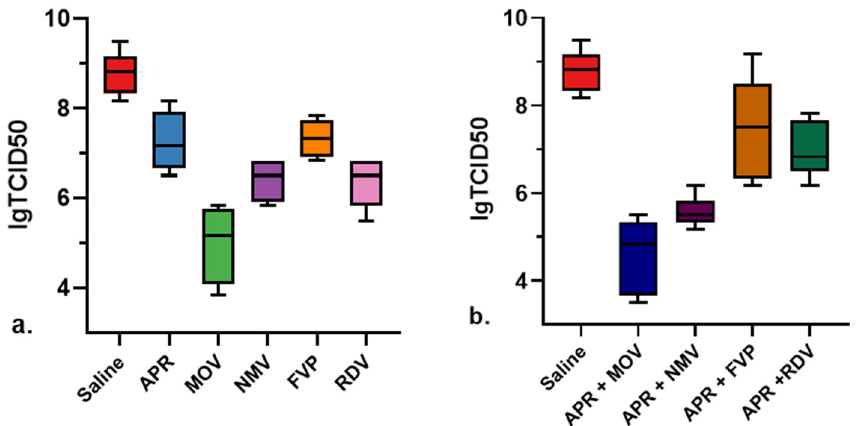
Figure 4. The titer value of the virus in the mouse lungs 4 days after infection (lgTCID50/mL) in a model of transgenic mice infected with the mouse-adapted SARS-CoV-2 strain when used monotherapy ( a ) and combination therapy ( b ).